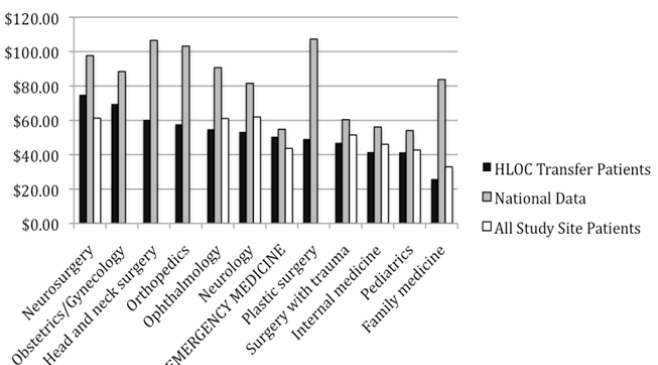
Figure 3 . Percent resource based relative value scale (%RBRVS) by specialty (n=12) for higher level of care (HLOC) transfer pa- tients (N=570).